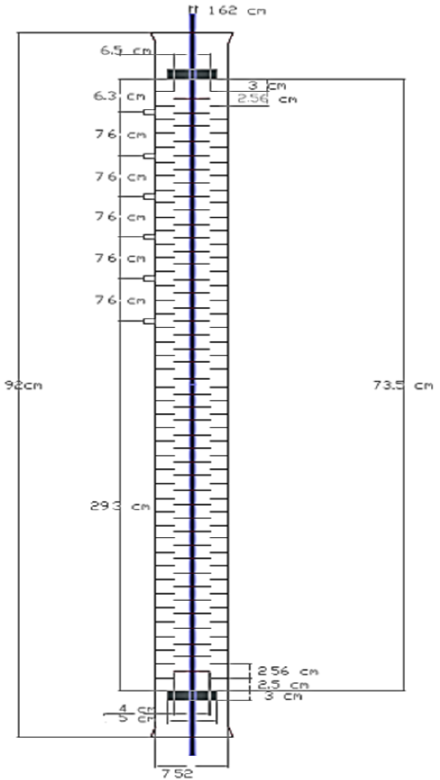
Figure 1. Schematic diagram of the rotating disc contactor (RDC) layout. The small column was fitted with two stainless steel perforated-distributor plates placed at opposite ends of the column, one for the dispersed phase and the other for the continuous phase A description of the four various distributors used in this effort is presented in Table 3. Table 3. Details of dispersed phase distributors.